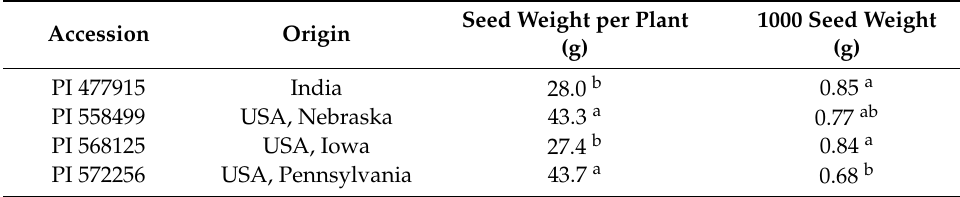
Table 1. Four studied Amaranthus hypochondriacus accessions.